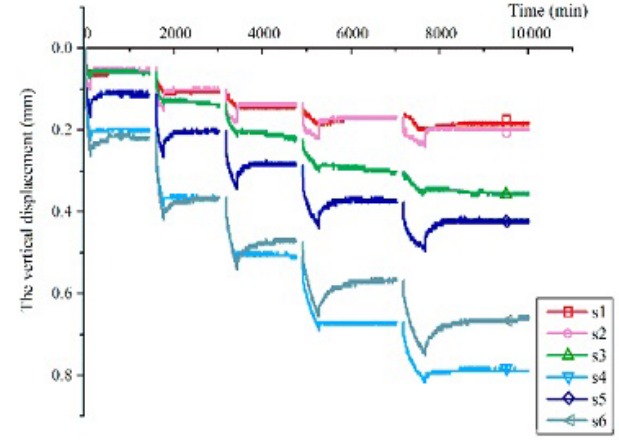
Figure 5. Cumulative vertical displacement of intermittent pump-